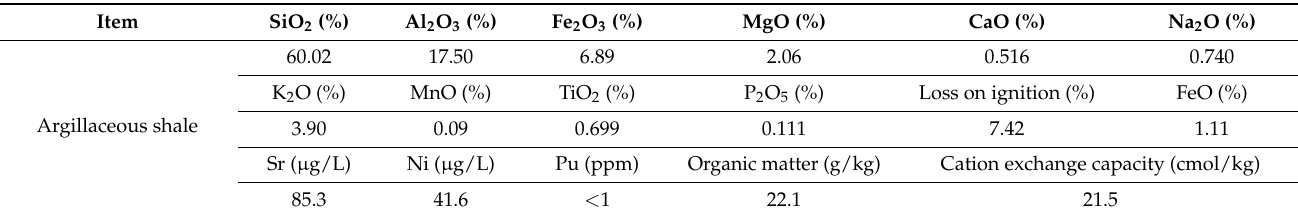
Table 2. Analysis results of argillaceous